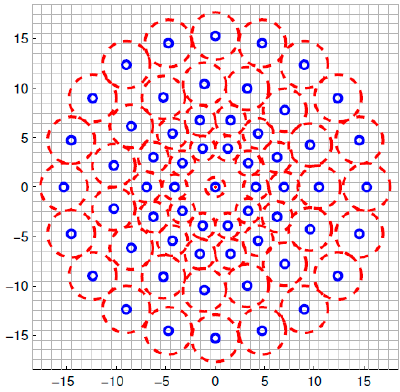
Figure 2. Binary Robust Invariant Scalable Keypoints (BRISK) sampling pattern.